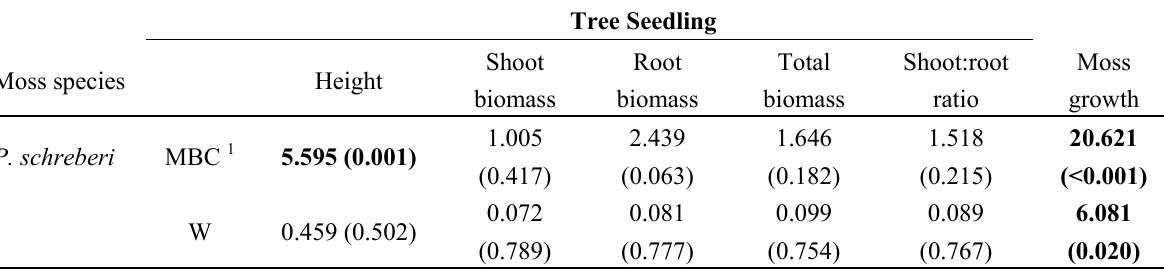
Table 2. The effect of moss biomass class (MBC) and precipitation frequency (W) on Pinus sylvestris seedling and moss growth for each of four moss species; there were no significant interaction effects between MBC and precipitation frequency for any of the species and response variables (results not presented); the values show the results ( F -value) and significant levels ( p -values) in parentheses of a two-way ANOVA with replicates organized into blocks (serving as a random factor); significant effects are shown in bold ( p <